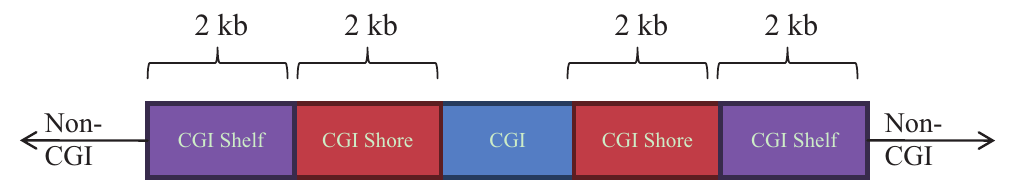
Figure 1. Illustration of a CpG island (CGI) with surrounding CGI shores, CGI-shelves and non-CGI